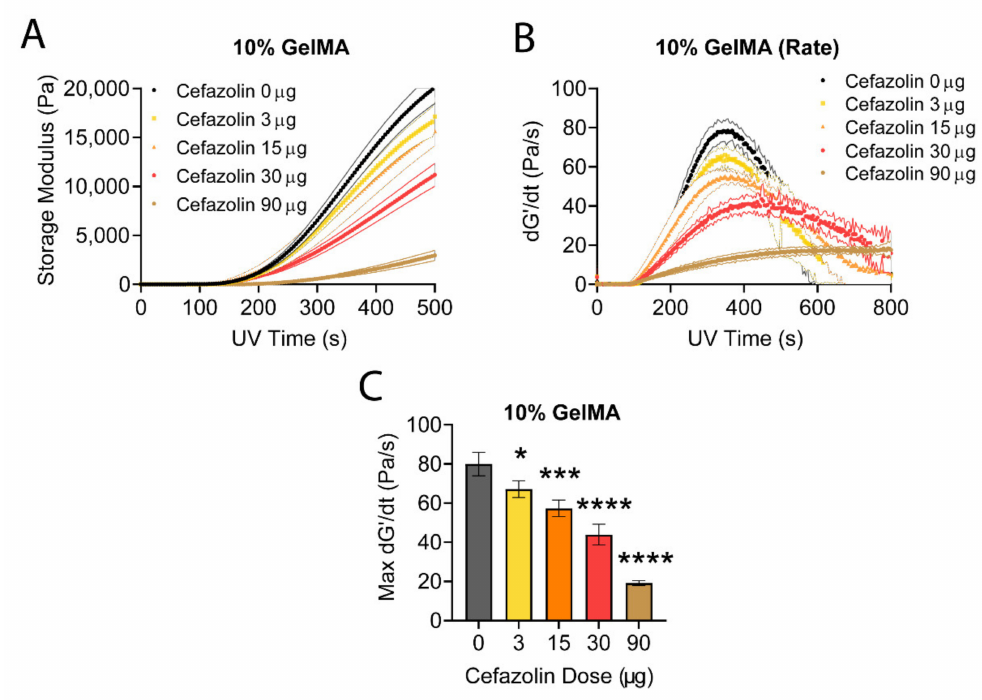
Figure 6. In situ photorheology of 10% GelMA-DDS hydrogels for the first 500 s of the crosslinking reaction. ( A ) Storage modulus. ( B ) Crosslinking reaction rate. ( C ) Maximum crosslinking reaction rates. Photocrosslinking with 0.5 mg/mL Irgacure 2959 at 365 nm. n = 5 samples for all groups. Error bands indicated the standard deviation for A and B. For C, symbols indicate statistical differences compared to the control group without cefazolin (* p < 0.05, *** p < 0.001, **** p <